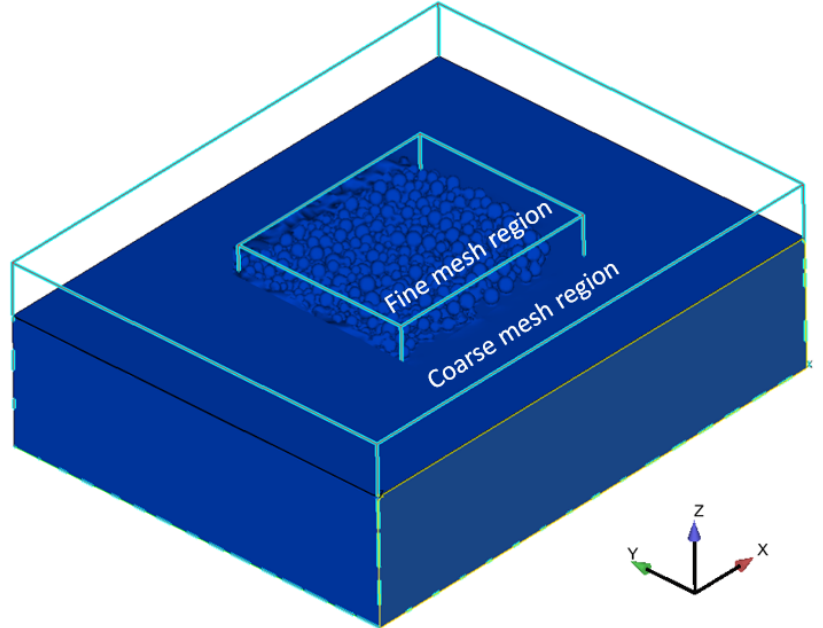
Figure 5. Simulation domain used for 0.5 mm scan length simulation.